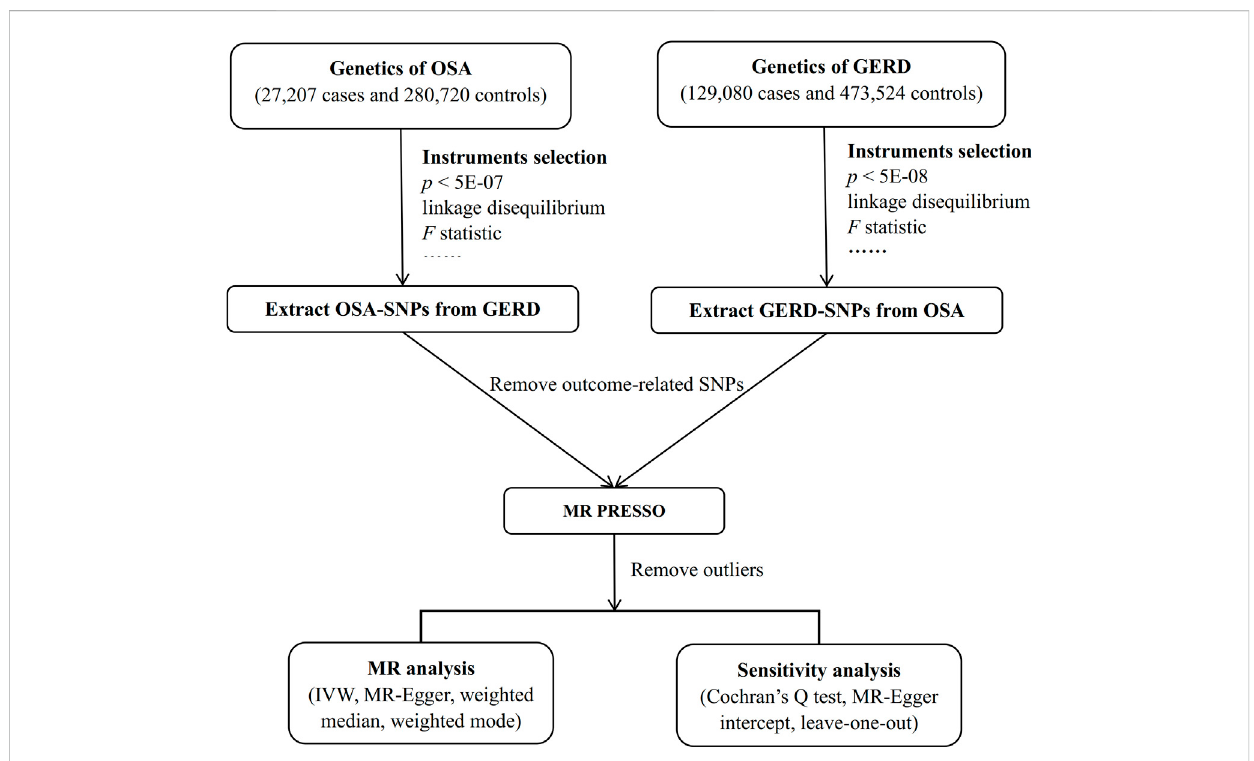
FIGURE 1 Work fl ow of the bidirectional two-sample MR study. Abbreviation: MR, Mendelian randomization; OSA, obstructive sleep apnea; GERD, gastroesophageal re fl ux disease; SNP, single nucleotide polymorphism; PRESSO, Pleiotropy REsidual Sum and Outlier; IVW, inverse variance